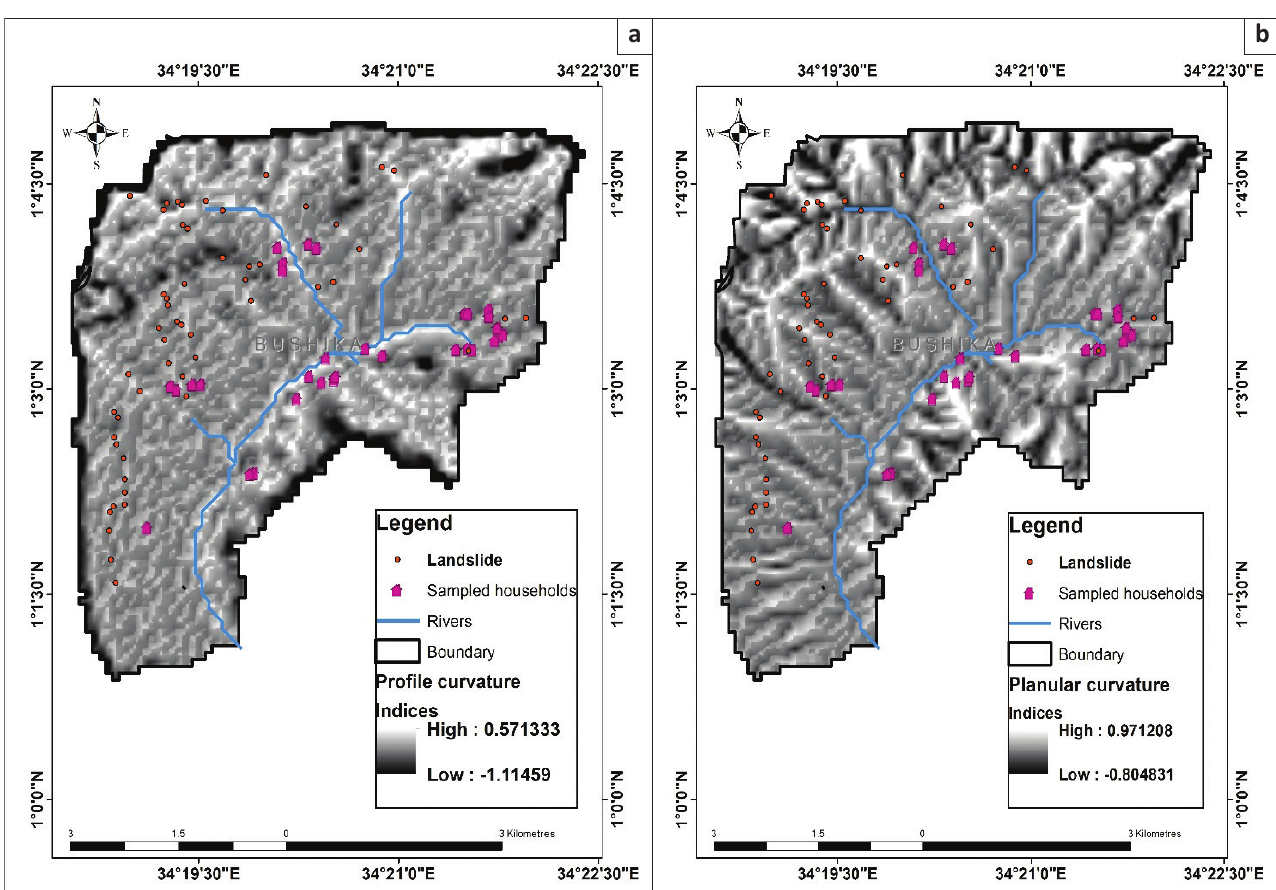
FIGURE 4: Landslide susceptibility of households for persons with disabilities due to slope curvature of (a) Profile curvature and (b) Planula curvature.